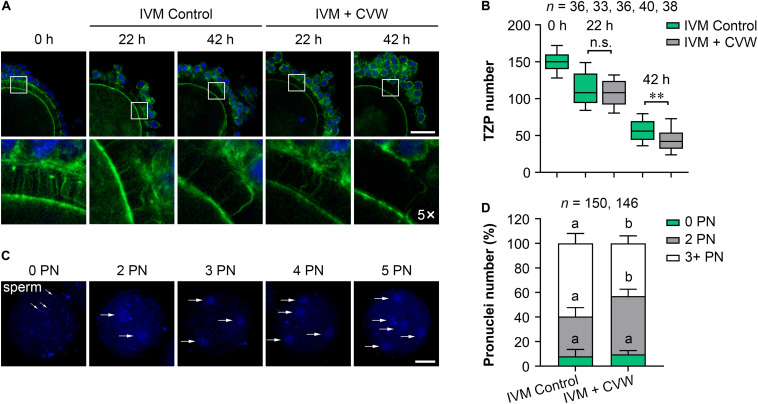
Effects of CVW on transzonal projection (TZP) retraction during IVM and polyspermic penetration after fertilization. (A) Representative images of actin-labeled TZPs (green) in control and CVW-treated cumulus oocyte complexes (COCs) at 0, 22, 42 h during IVM. Cumulus cell nuclei are stained blue. The hollow squares represent five-fold enlarged images of TZPs in different groups. Scale bar = 30 μm. (B) Box plot shows the numbers of TZPs in control and CVW-treated COCs at 0, 22, 42 h during IVM. All middle lines in box plot indicate the median, the edges indicate the 25th/75th percentiles and the whiskers indicate the 10th/90th percentiles. n.s., not significant. ∗∗P < 0.01 (Student’s t-test). (C) Representative images of putative zygotes with different numbers of pronuclei (PN) (horizontal arrows) at 18 h after fertilization. Scale bar = 30 μm. (D) Percentage of putative zygotes with different numbers of PN in control and CVW-treated groups. Error bars represent the SD in five replicates. Different superscripts indicate P < 0.05 (Student’s t-test).